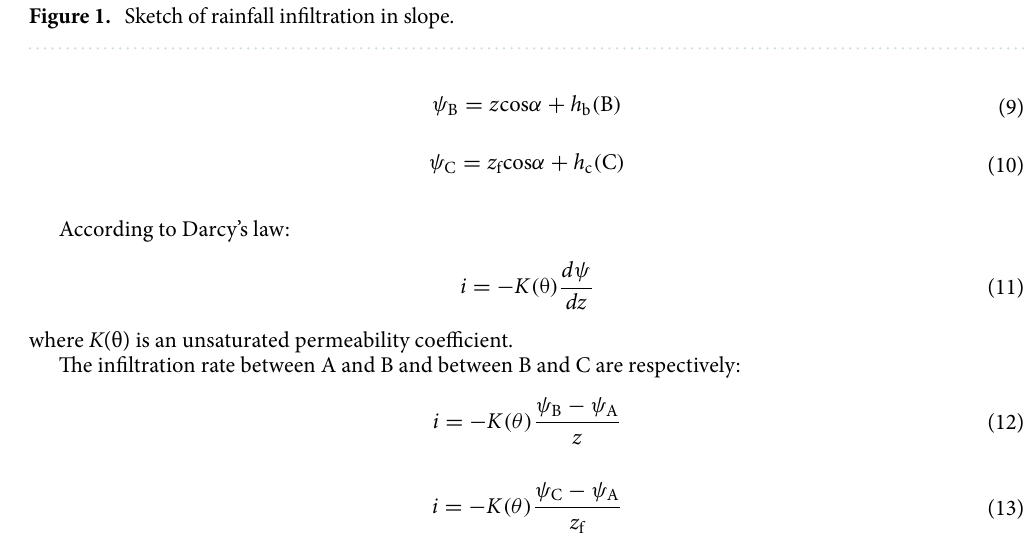
Figure 1. Sketch of rainfall infiltration in